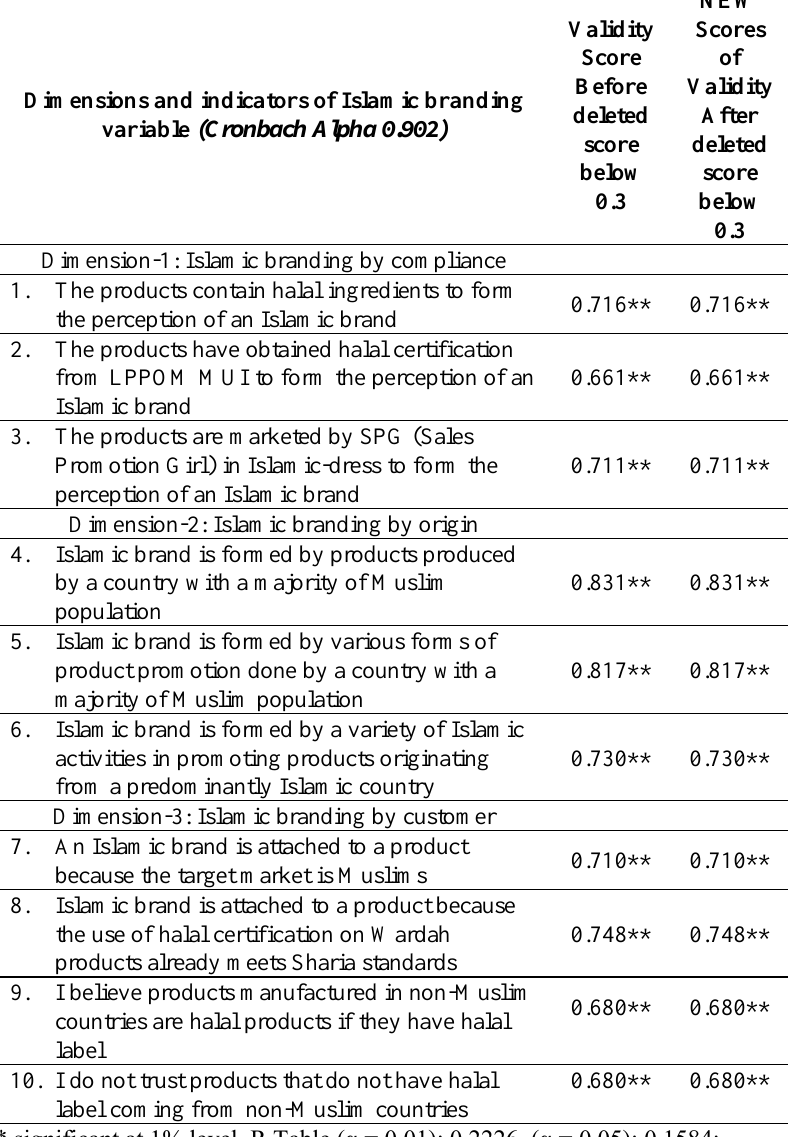
Table 2 The results of validity test: Islamic branding variable Dimensions and indicators of Islamic branding variable (Cronbach Alpha 0.902)